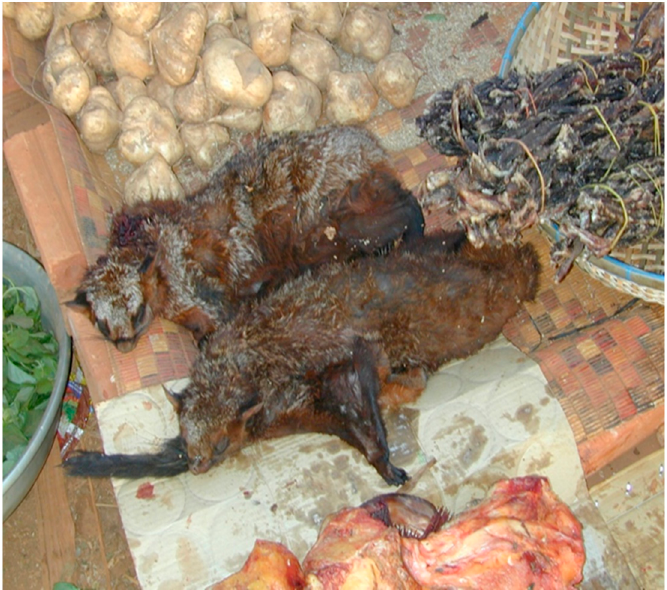
Figure 3. Flying fox bat (center), parrots (right) in market, Prey Meas goldmine, Ratannikiri province (T. Murphy).